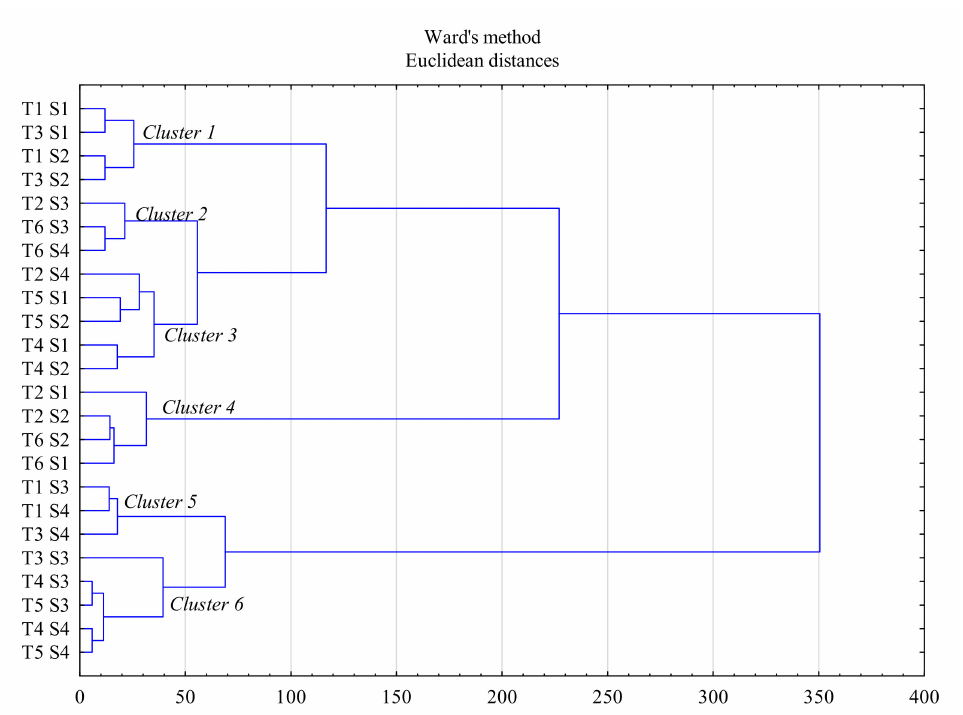
Figure 2. Dendrogram analysis of physicochemical and microbial soil characteristics, depending on the tillage method and stubble management (Factors T and S: see Table 1).